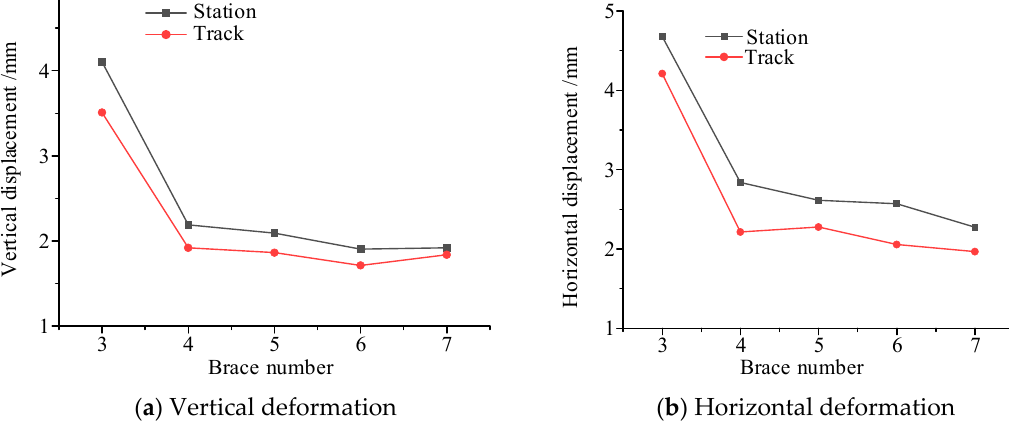
Figure 28. Maximum vertical and horizontal deformation values of stations and tracks under different numbers of interbracings.